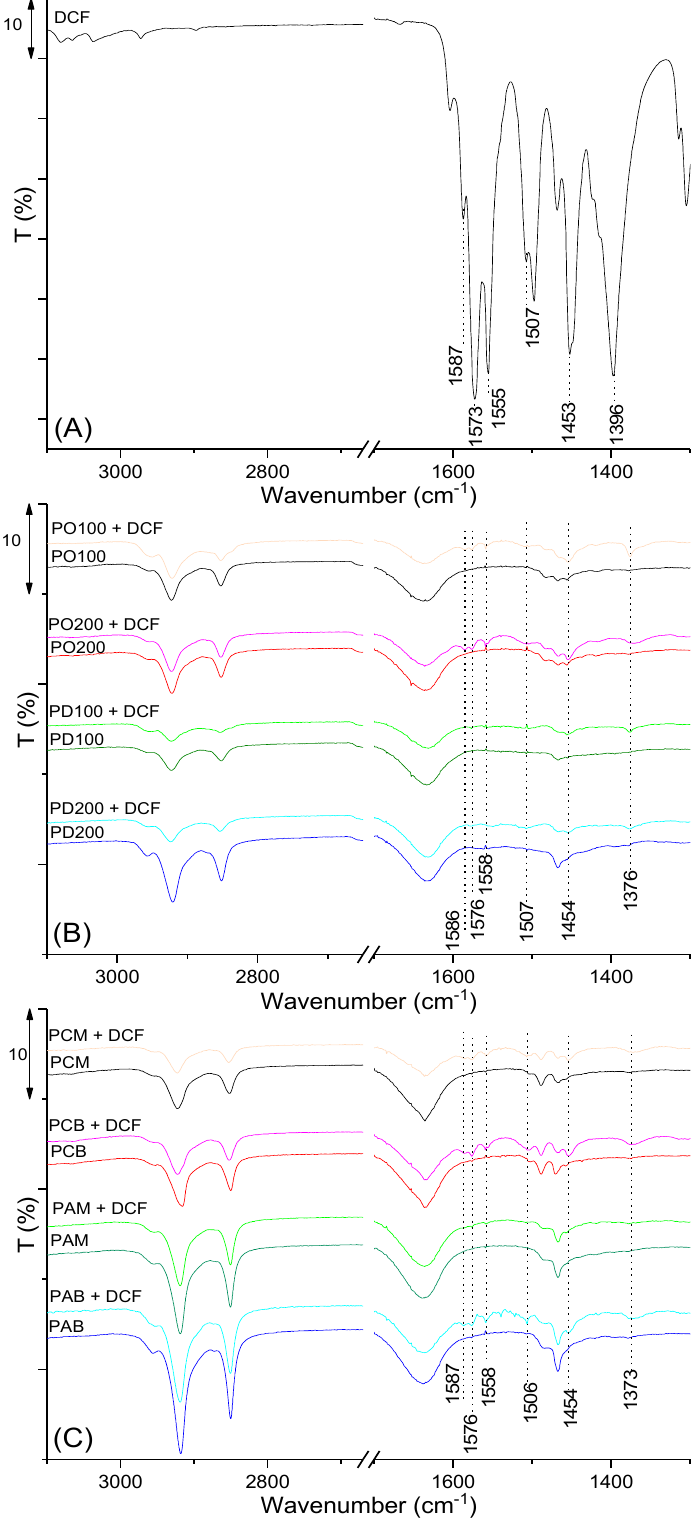
Figure 5. FTIR–ATR spectra of: DCF ( A ), spectra of P composites with dodecylamine and octade- cyldimethylbenzylammonium chloride (PO100, PO200, PD100, and PD200) before and after adsorp- tion of DCF ( B ), and spectra of P composites with cetylpyridinium chloride and Arquad ® 2HT-75 (PCM, PCB, PAM, and PAB) before and after adsorption of DCF [29] ( C ).